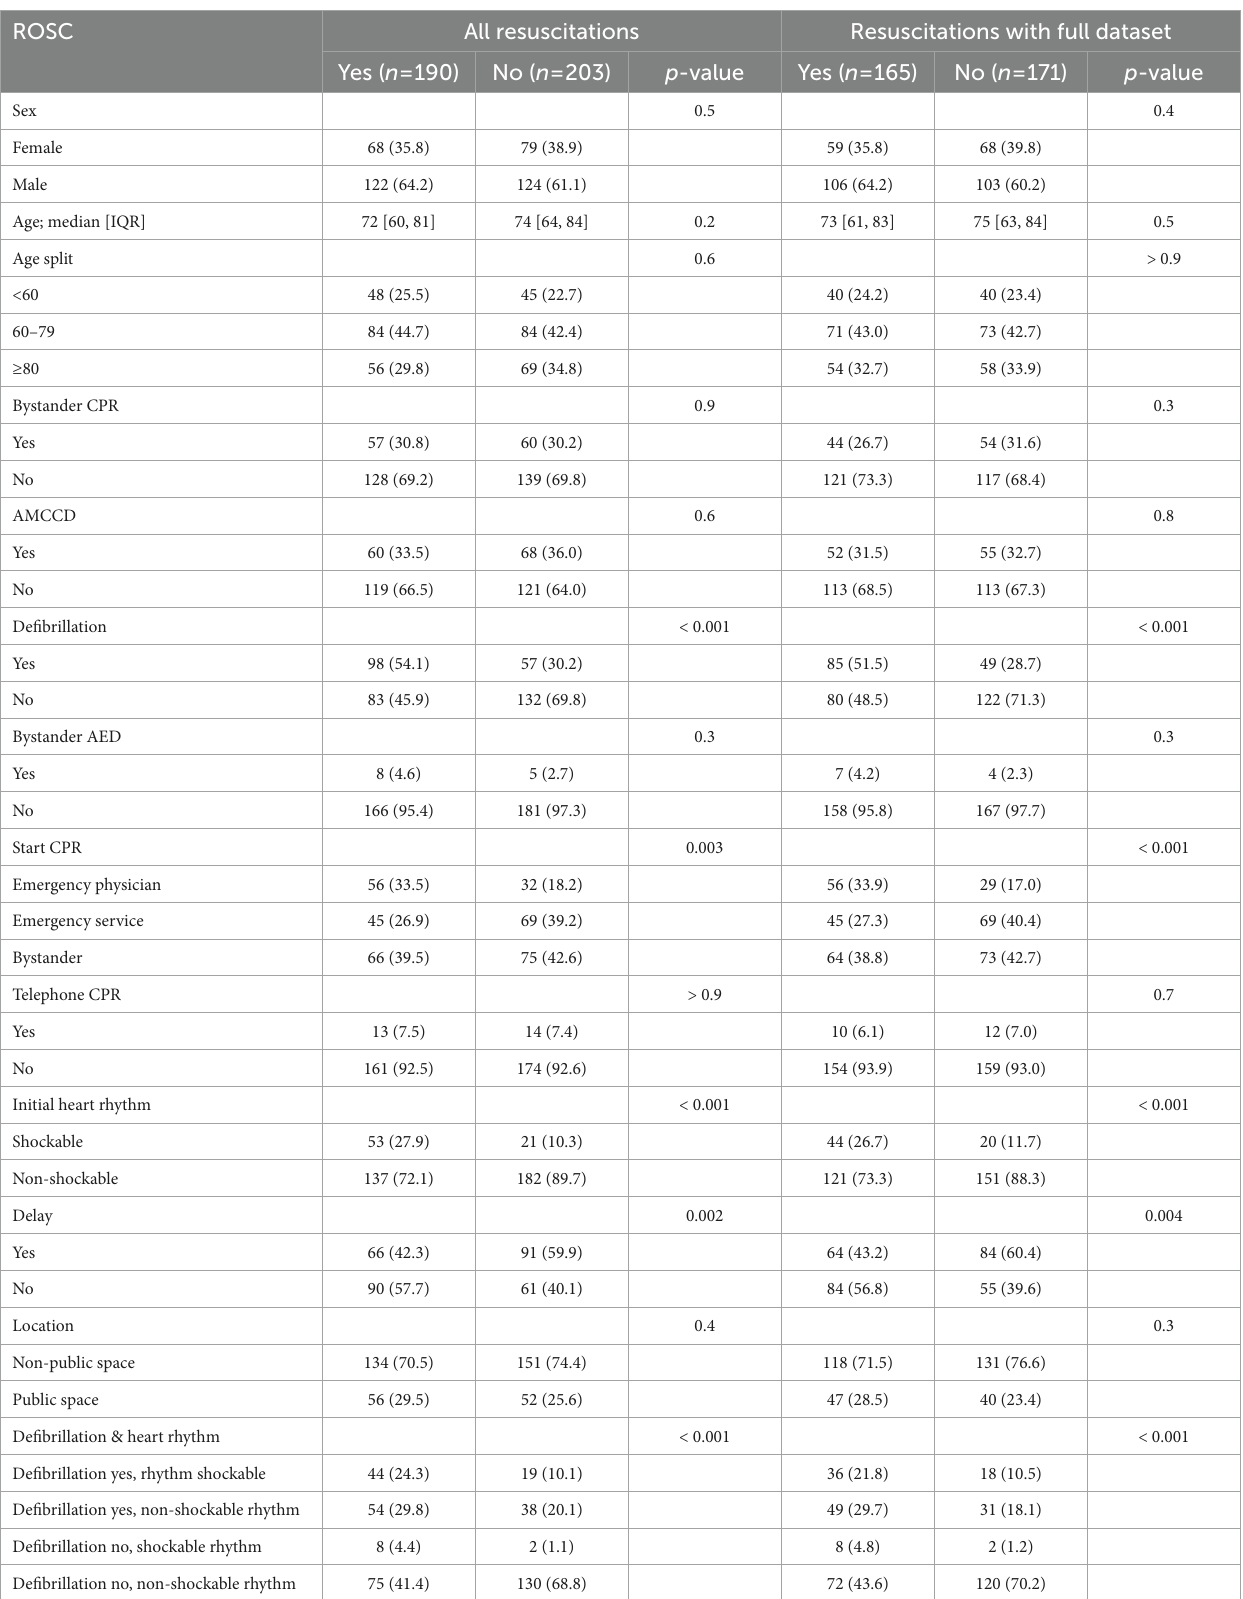
TABLE 3 Univariate analysis of the return of spontaneous circulation (ROSC) at least once compared to no ROSC. ROSC All resuscitations Resuscitations with full